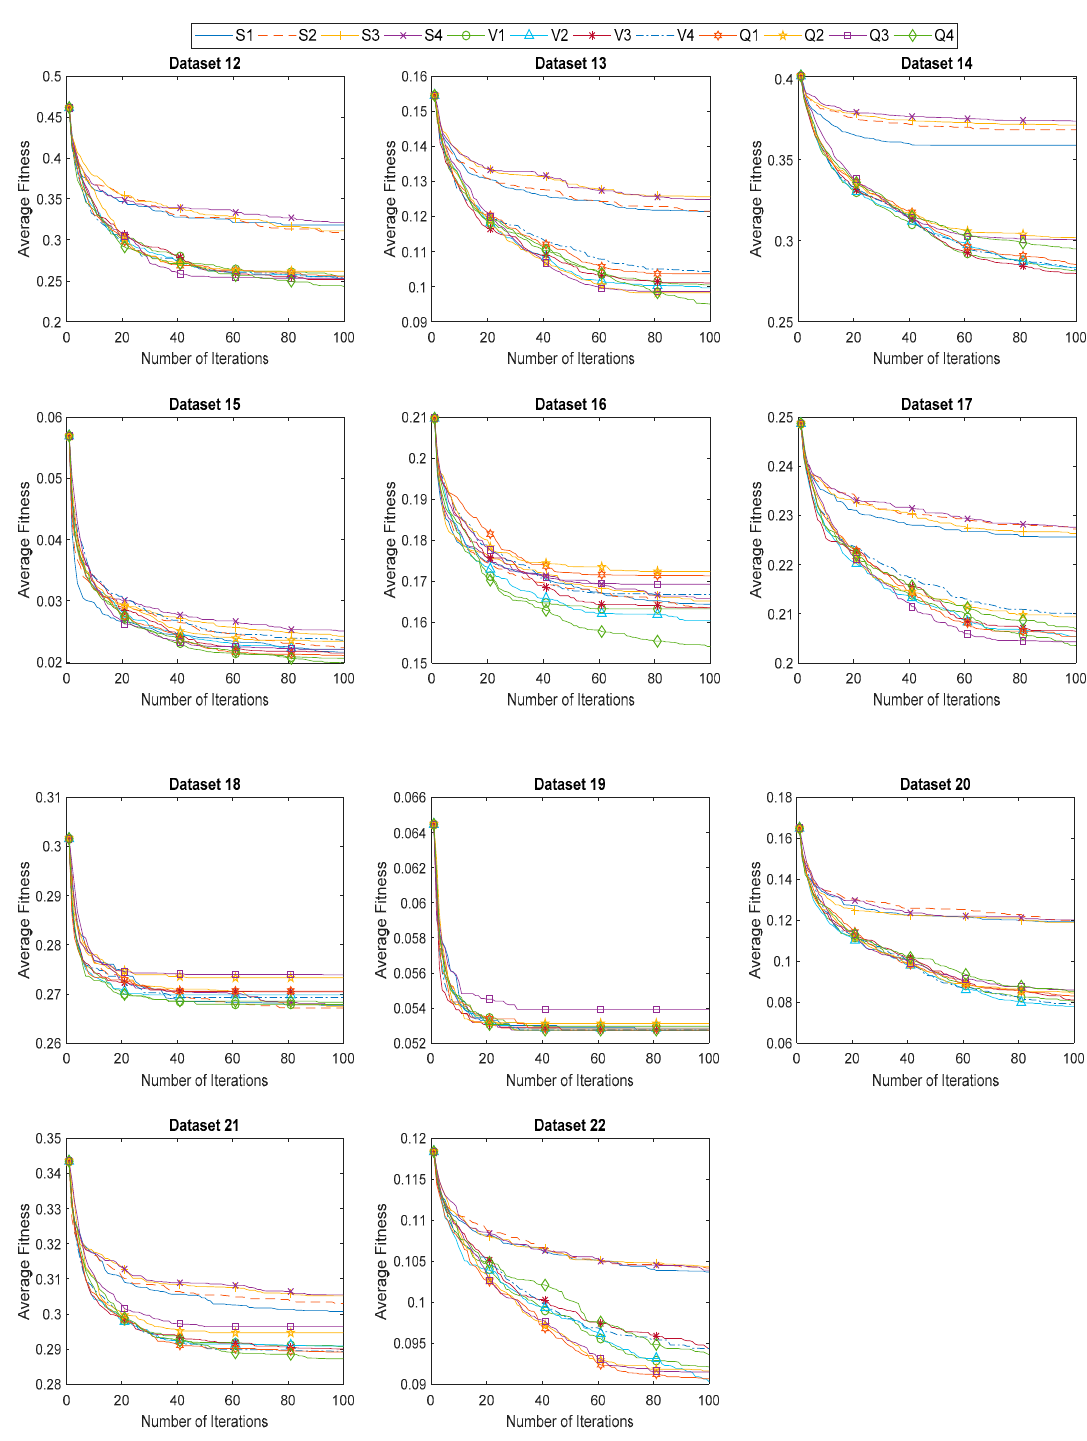
Figure 6. Convergence curves of proposed algorithms on datasets 12–22.